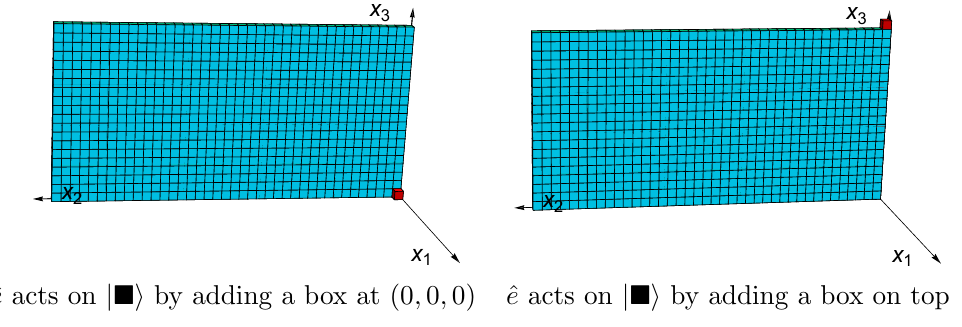
Figure 12 . The (cid:12)rst hatted descendants of